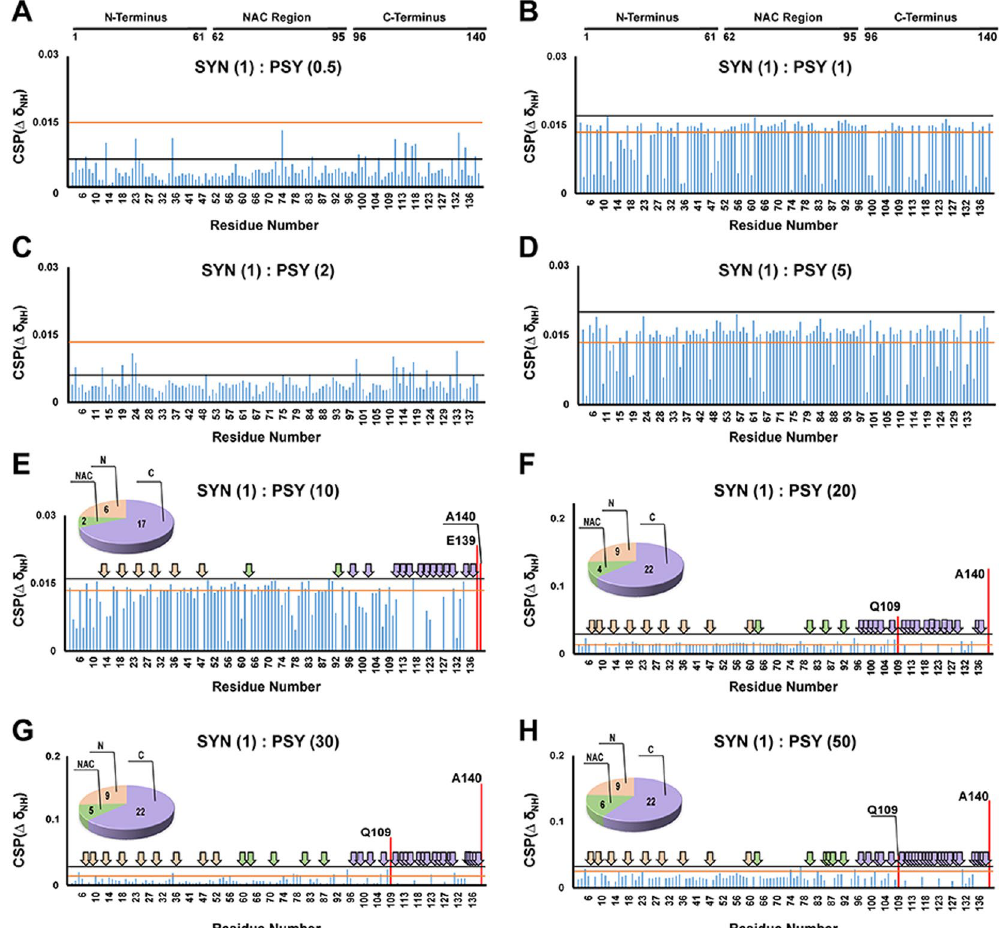
Figure 4. Psychosine interaction with α -synuclein at different concentrations. CSPs in full-length α -synuclein (20 µ M) with psychosine indicated no significant effects at the following ratios: α -synuclein (1) psychosine (0.5) ( A ); α -synuclein (1):psychosine (1) ( B ); α -synuclein (1) psychosine (2) ( C ); α -synuclein (1) psychosine (5) ( D ). Significant CSPs and line-broadening of signals were observed at the following molar ratios: α -synuclein (1) psychosine (10) ( E ); α -synuclein (1) psychosine (20) ( F ); α -synuclein (1) psychosine (30) ( G ); α -synuclein (1) psychosine (50) ( H ). The black horizontal line represents the CSP mean plus one SD. The orange horizontal line represents the maximum CSP due to spectral variability between different α -synuclein samples. CSPs higher than both the black and orange lines were considered significant and marked in red. The broadened- beyond-detection signals were assigned by arrows marked in pink in the N-terminus, green in the NAC region, and purple in the C-terminus. The number of signals that were broadened are presented in a pie chart. PSY = psychosine; SYN = α